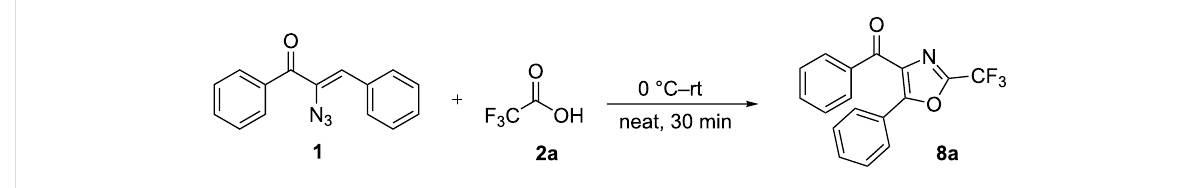
Scheme 5: Oxazole formation.